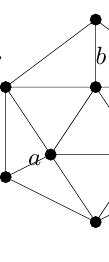
Fig. 7: A claw-free graph that does not have a 1-bend EPG